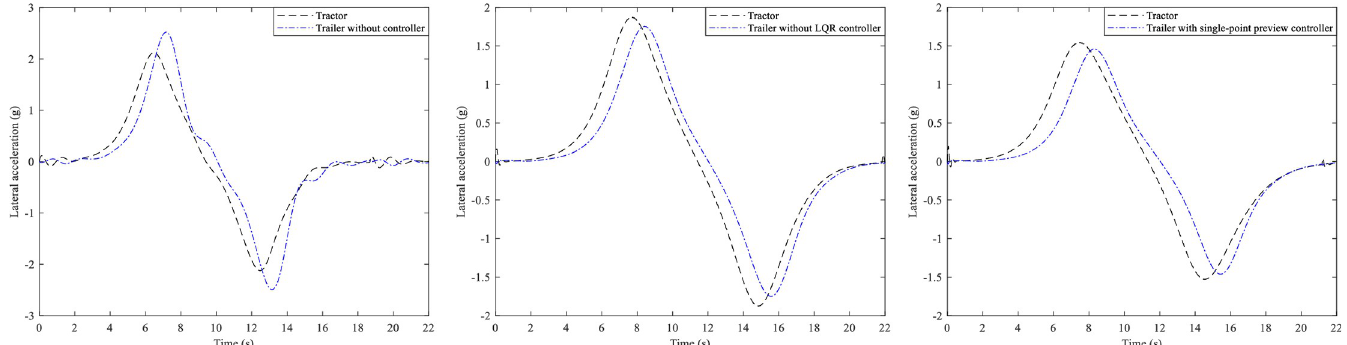
Fig 8. Lateral acceleration curves. (A) Trailer without controller. (B) Trailer with LQR controller. (C) Trailer with single-point preview controller.